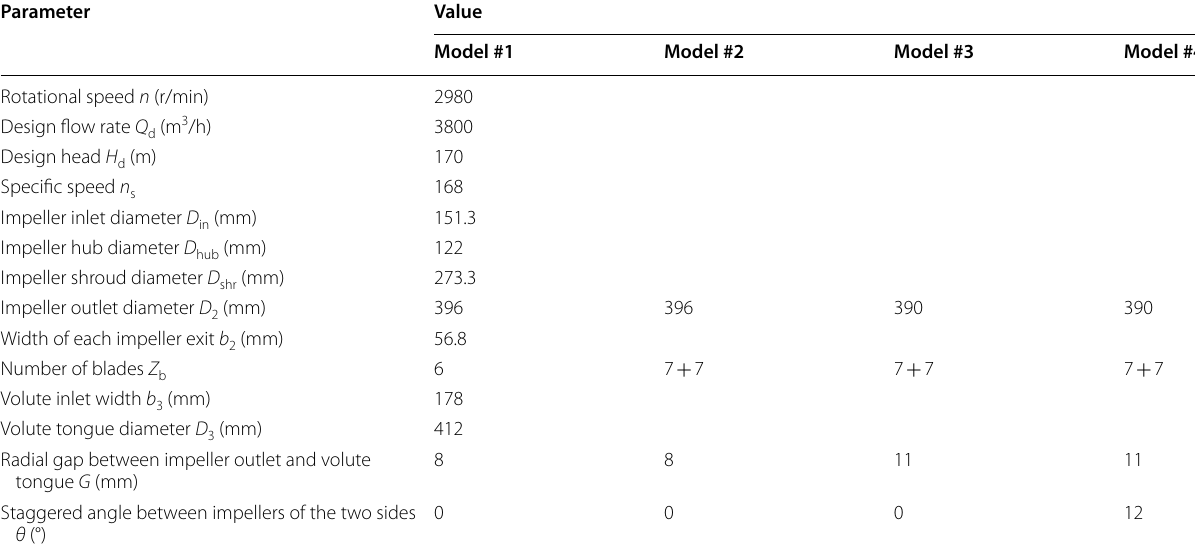
Table 1 Essential parameters of the pump